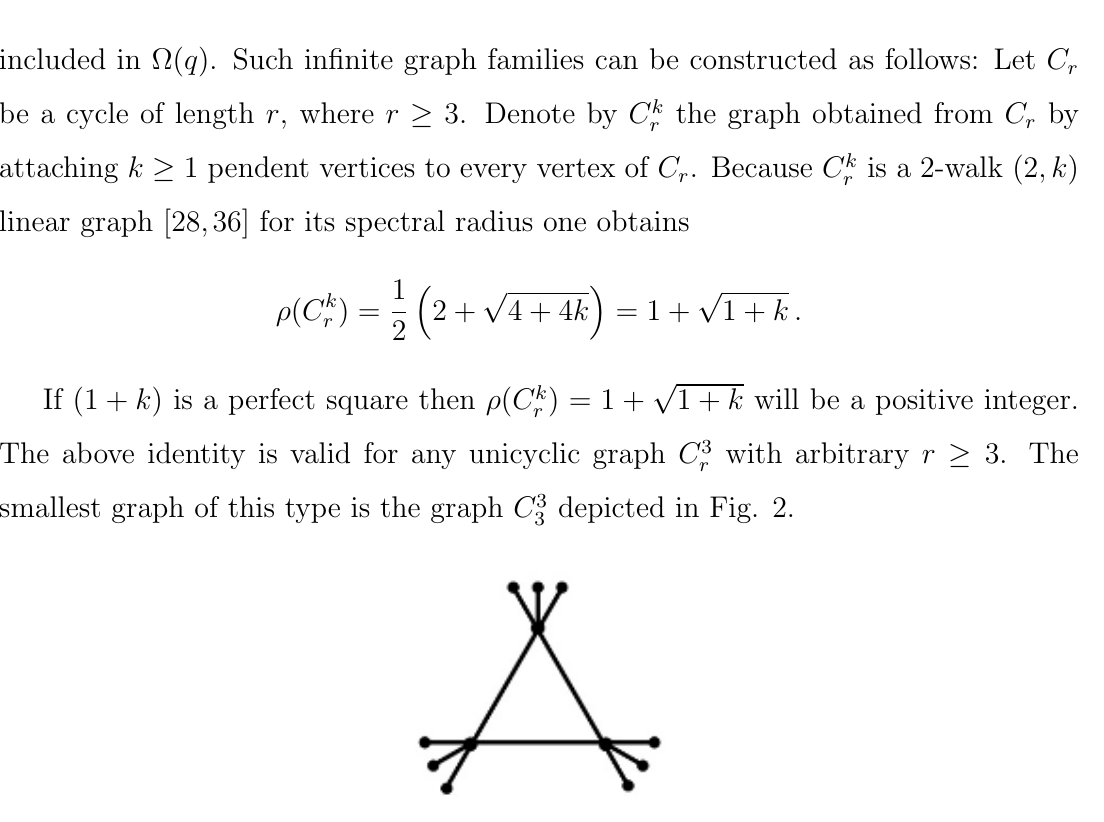
graph with a spectral radius 3